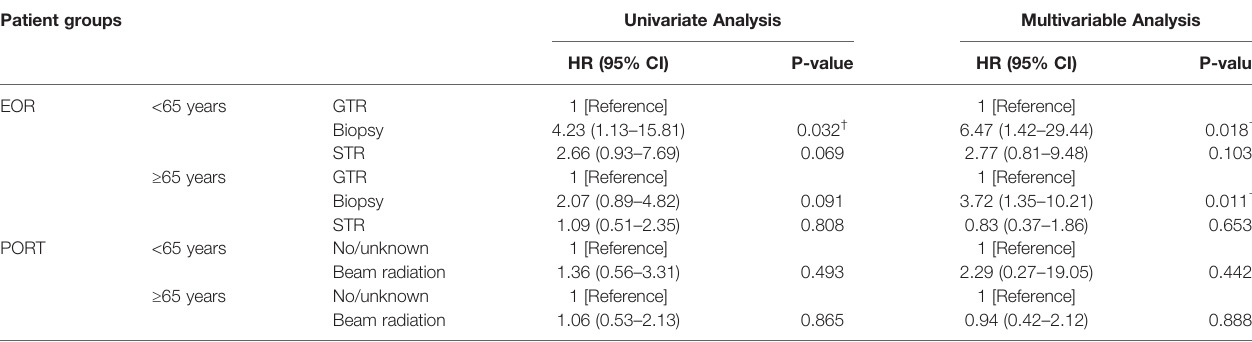
TABLE 3 | Results of univariate and multivariable Cox proportional regression analysis of EOR and PORT in different age groups. Patient groups